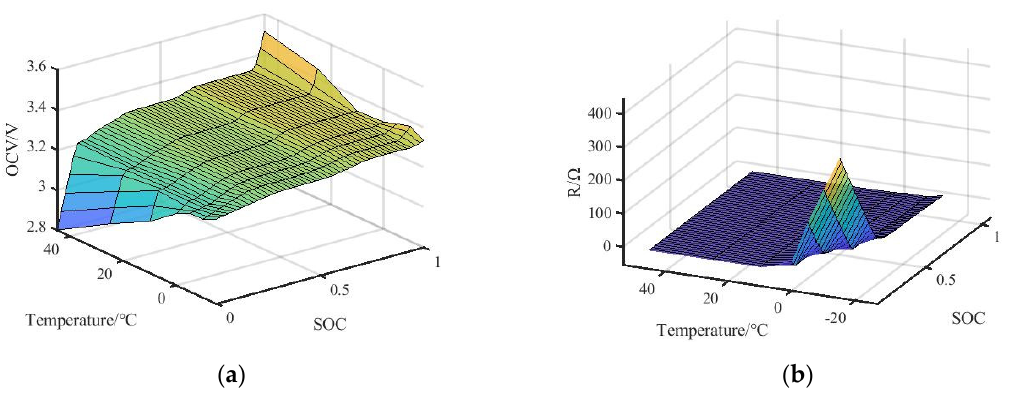
Figure 3. Parameter maps: ( a ) open-circuit voltage and ( b )